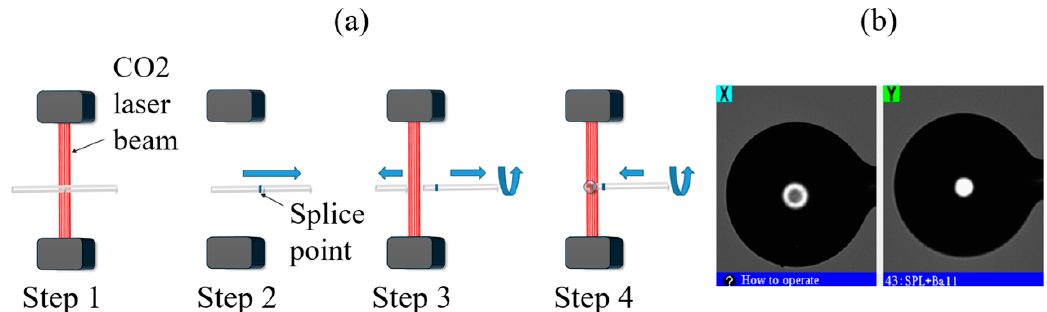
Figure 2. Ball resonator fabrication process. ( a ) Schematics of the fabrication process using a CO 2 laser. ( b ) Photographic image of one resonator from X and Y cameras.